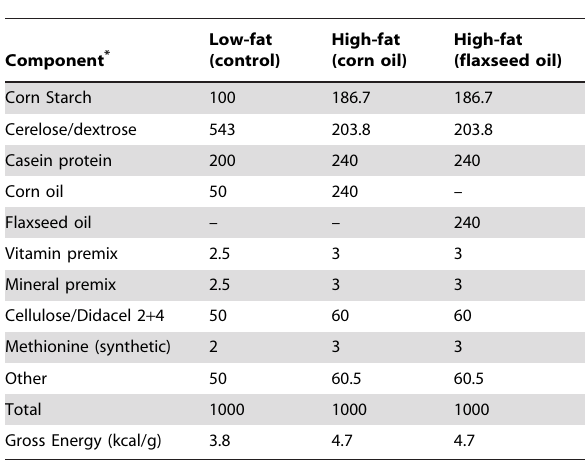
Table 7. Composition of treatment